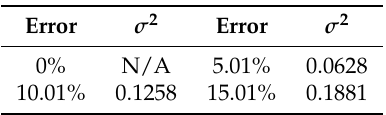
Table 4. input parameters for simulations.